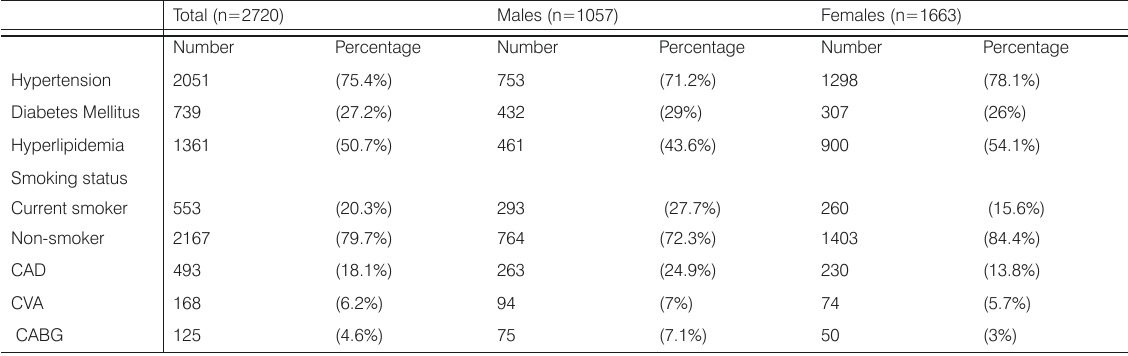
Table 2. Distribution of cardiovascular risk factors and cardiovascular disease by